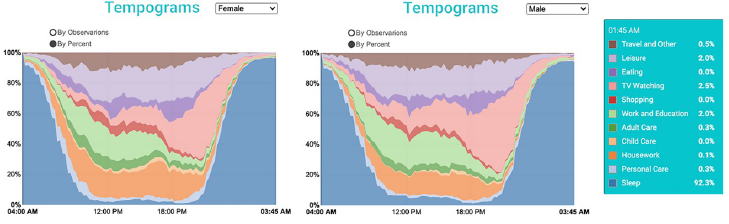
Fig 3. Tempograms of time use diaries for women (left) and men (right) caregivers. Source: IPUMS ATUS Extractor: Sample of self-identified family caregivers from 2011–2019.